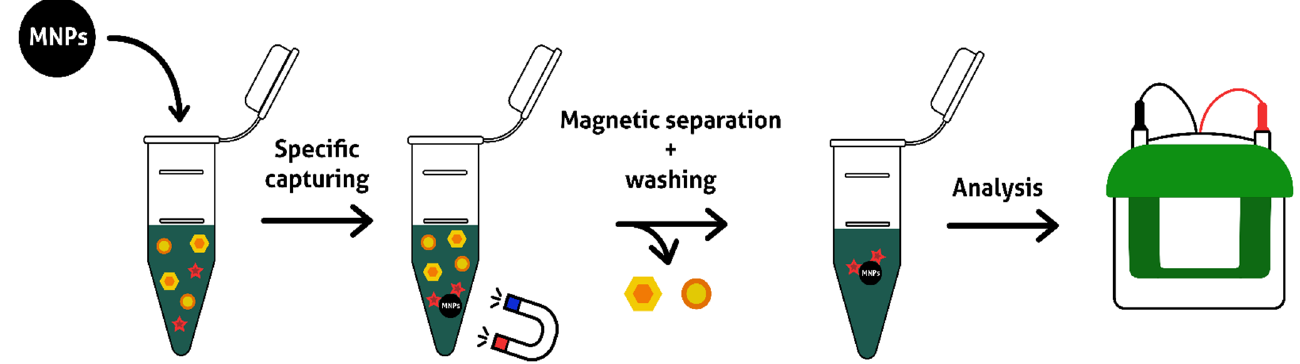
Figure 7. Basic principles of magnetic separation. Magnetically separated targets may be released and analyzed by various physical and biochemical methods. Hexagon, circle, and star are analytes in the solution. The star is a specific analyte, which can be bound for the MNPs surface.